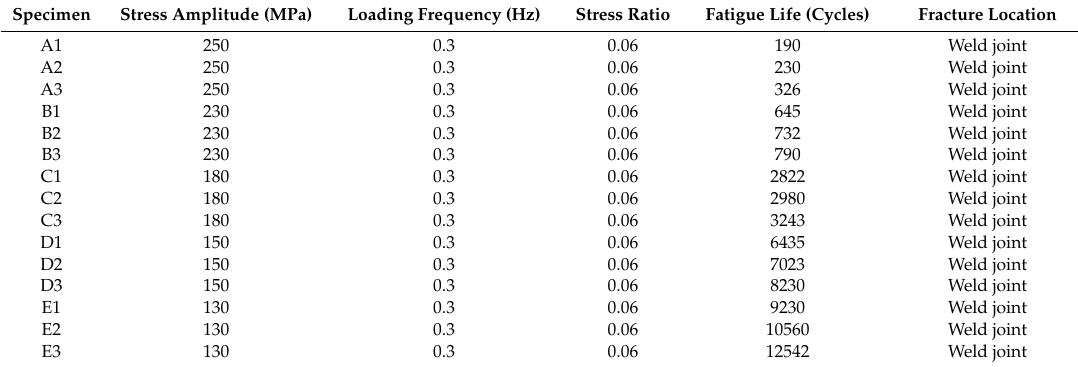
Table 4. Corrosion fatigue results of 7075 aluminum alloy FSW